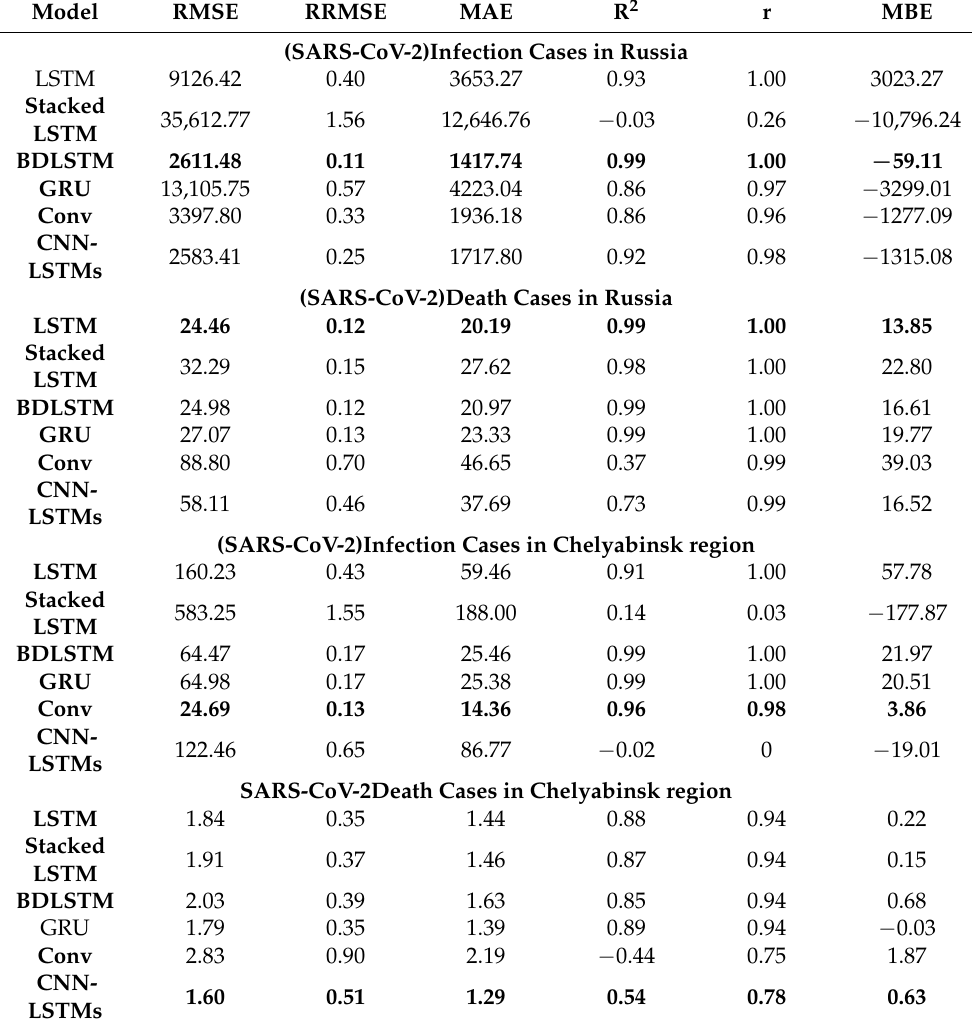
Table 1. Comparison of six methods evaluation testing 20% SARS-CoV-2 daily infection and death cases in Russian federation and